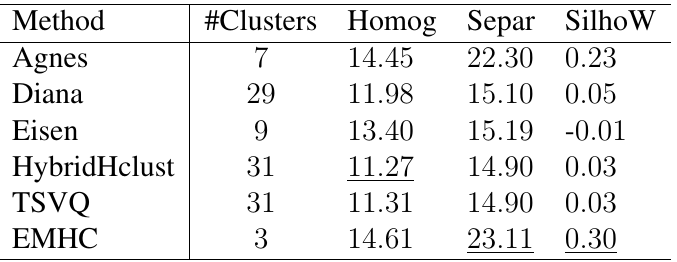
Table 3: Local cluster validity of EMHC vs. five hierarchical clustering methods based on the best clustering of each output dendrogram from the lung data